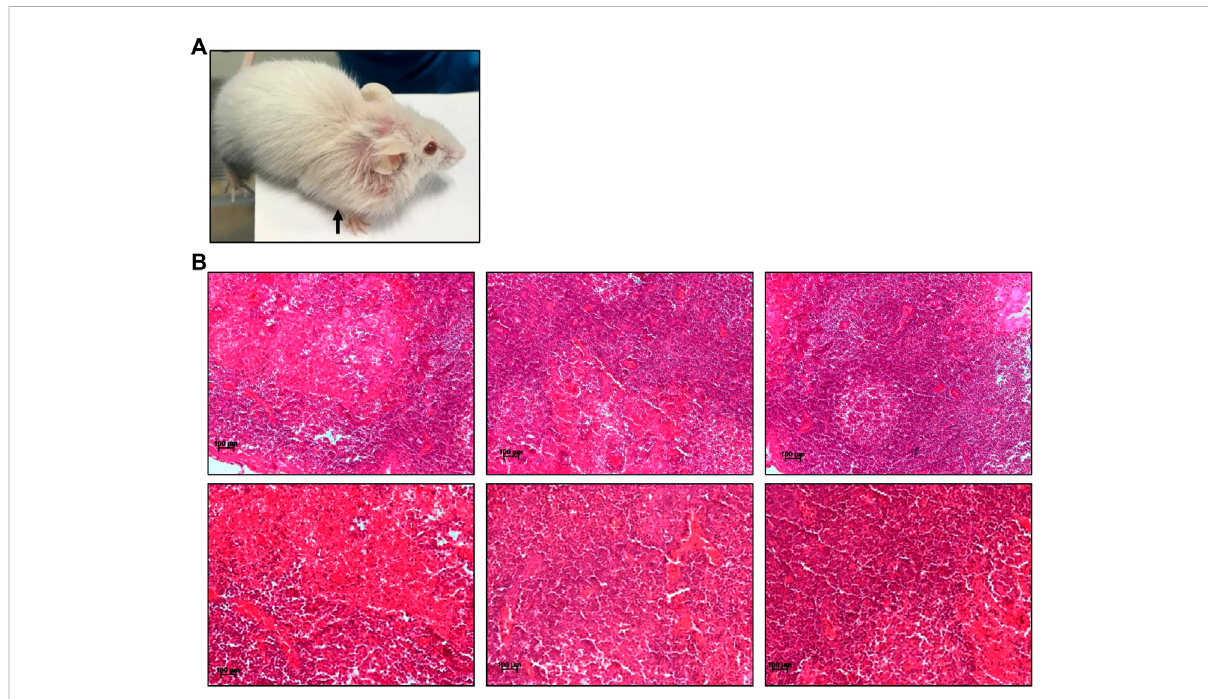
FIGURE 9 Histopathological examination of abnormal growth in ES-exposed mice post treatment. (A) Abnormal growth in neck region observed after 3 months of ES exposure indicated by black arrow in ES-exposed female mice (5 mg/kg, 10 doses). (B) Histology of abnormal tissue from the neck region oftheES-exposed female mice(×20).Experimentwasrepeatedthreeindependenttimes fromthetissues ofsameanimal.Scalebar:100 μ